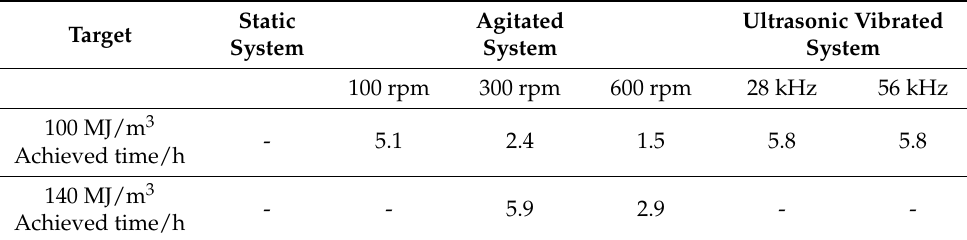
Table 3. The time to achieve the target thermal energy storage